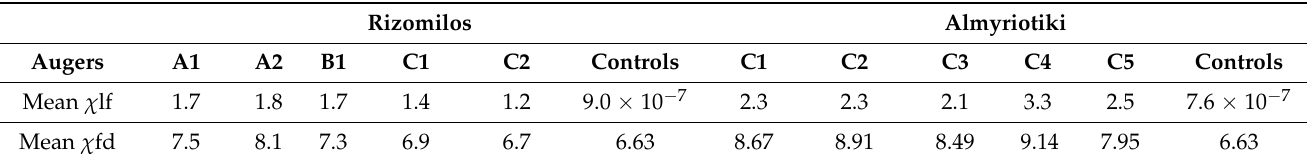
Table 4. Mean values of the low-frequency magnetic susceptibility (10 − 6 m 3 kg − 1 ) and frequency dependence (%) at Rizomilos and